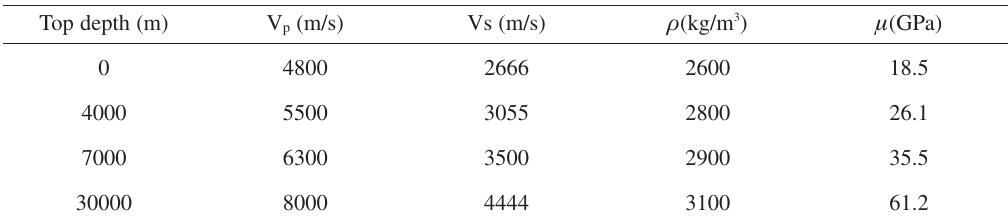
Table I. Crustal model used by Hernandez et al. (2004). The rigidity modulus is indicated with µ . Top depth (m)